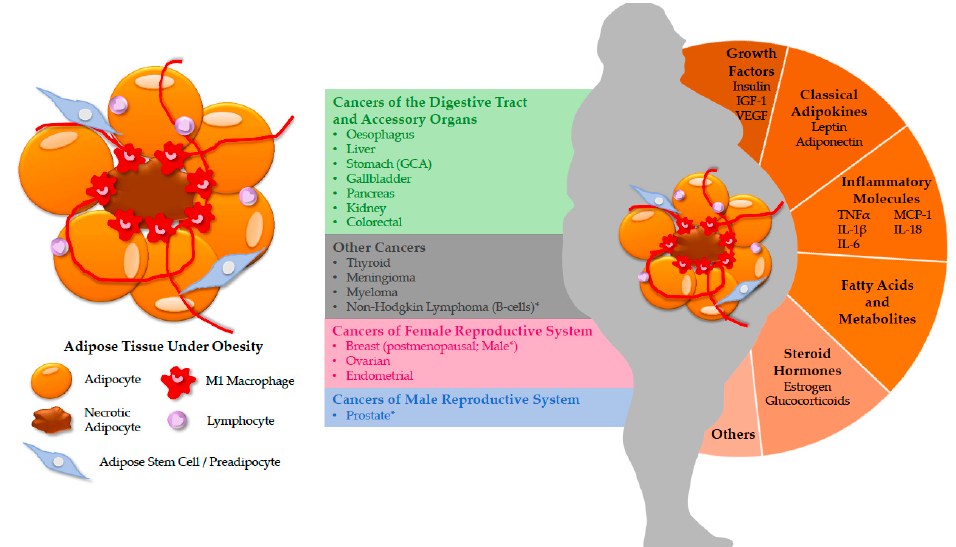
Figure 1. Obesity has been linked to more than 13 types of cancers in the body. The white adipose tissue (WAT) is home to diverse cell types: adipocytes, adipose stem cells, endothelial cells and many resident and infiltrating immune cells. During obesity, WAT releases a plethora of molecules with autocrine, paracrine and endocrine functions, including growth factors, adipokines, pro-inflammatory molecules, fatty acids (FA) and lipid metabolites and many others, which create a favorable condition for cancer to develop. Obesity has been shown to increase the risk of 13 cancer types and 3 others with limited evidence (*) [5]. The link(s) between obesity and its complications to multiple cancer types observed in humans are currently unknown. GCA: gastric cardia adenocarcinoma; IGF: insulin-like growth factor; VEGF: vascular endothelial growth factor; IL: interleukin. TNF: tumor necrosis factor; MCP: monocyte chemoattractant